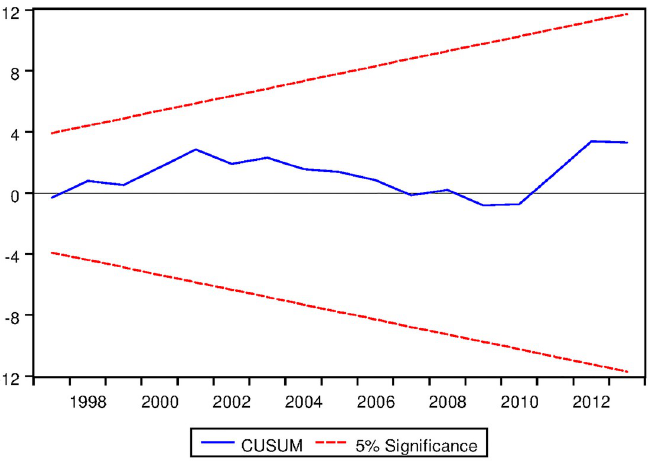
Fig 16. Stability diagnostic of cointegrating relationship for Australian data with linear trend as fixed regressor under proposed framework.